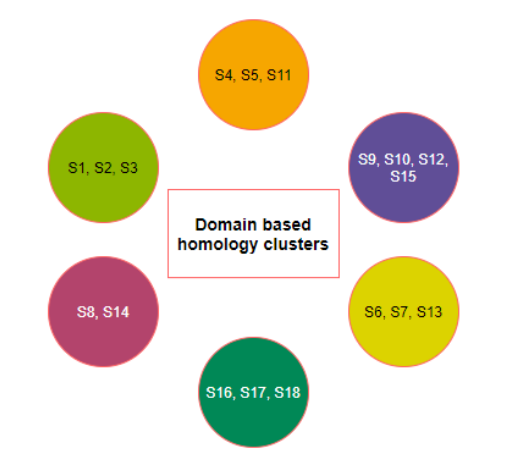
Figure 3. Clusters of species based on domain-based sequence